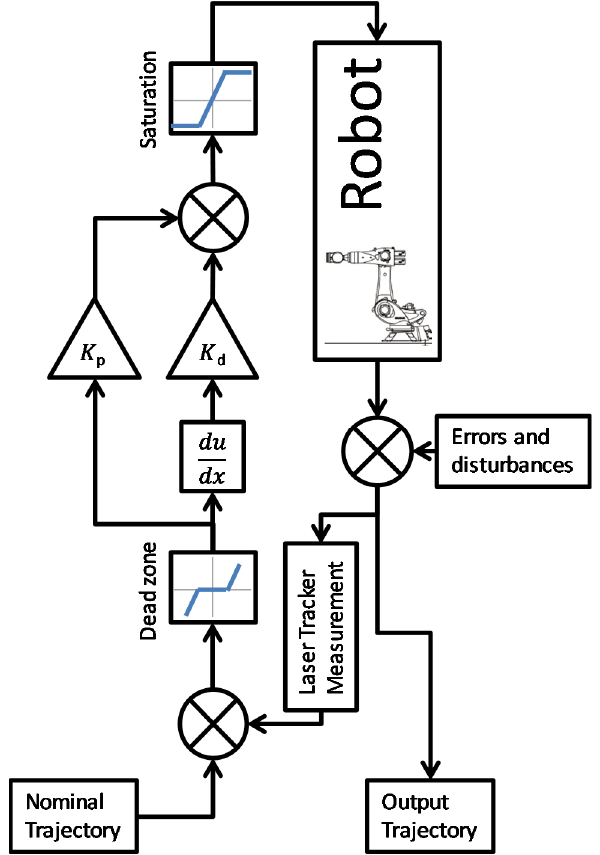
Figure 9. Main controller loop.